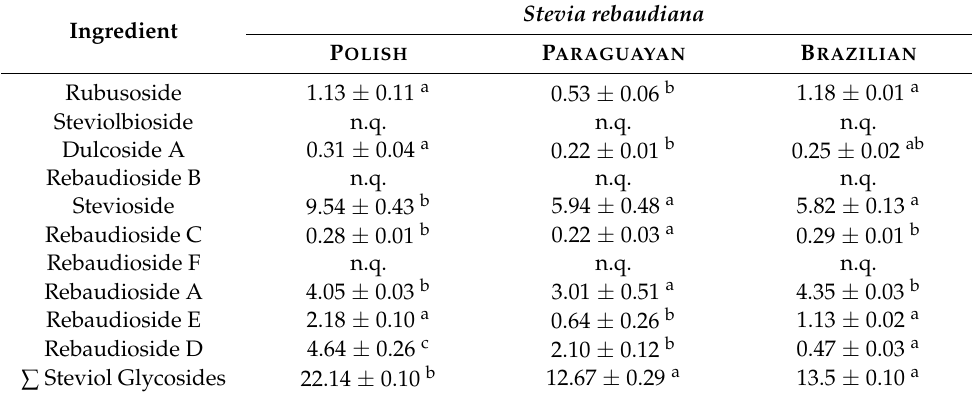
Table 2. Concentration of steviol glycosides (mg/100 g DM) in dried leaves of Stevia rebaudiana Bertoni, depending on the country of